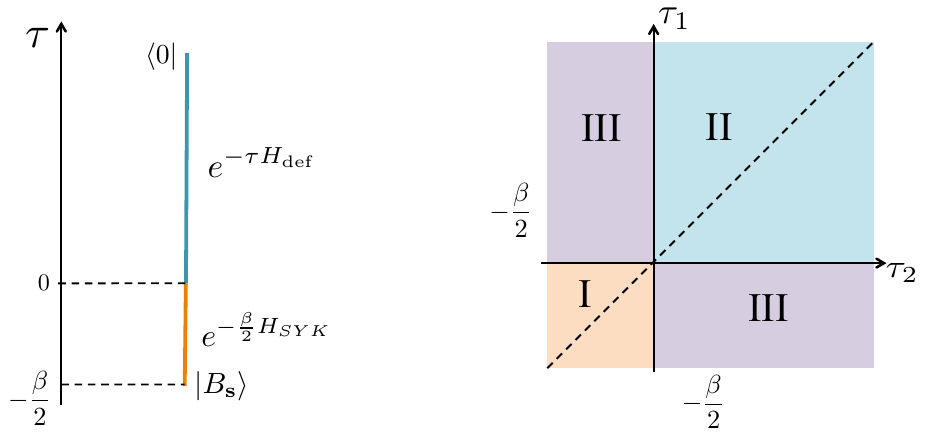
Figure 20 . Left: the illustration of the Euclidean path integral for the computation of the overlap. Right: the Euclidean path integral for two time variable. We divide the region to three parts depending on which Hamiltonian is used in the Euclidean time